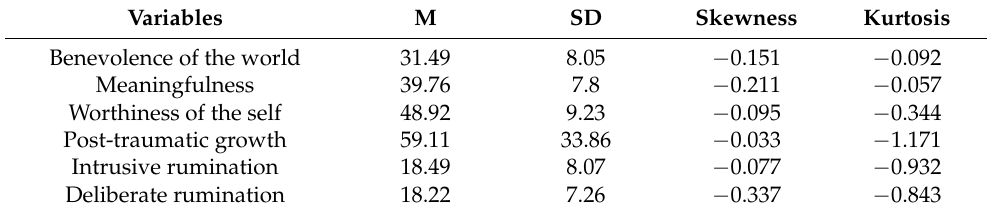
Table 2. Descriptive statistics of world assumptions, post-traumatic growth, and rumination (N = 215).